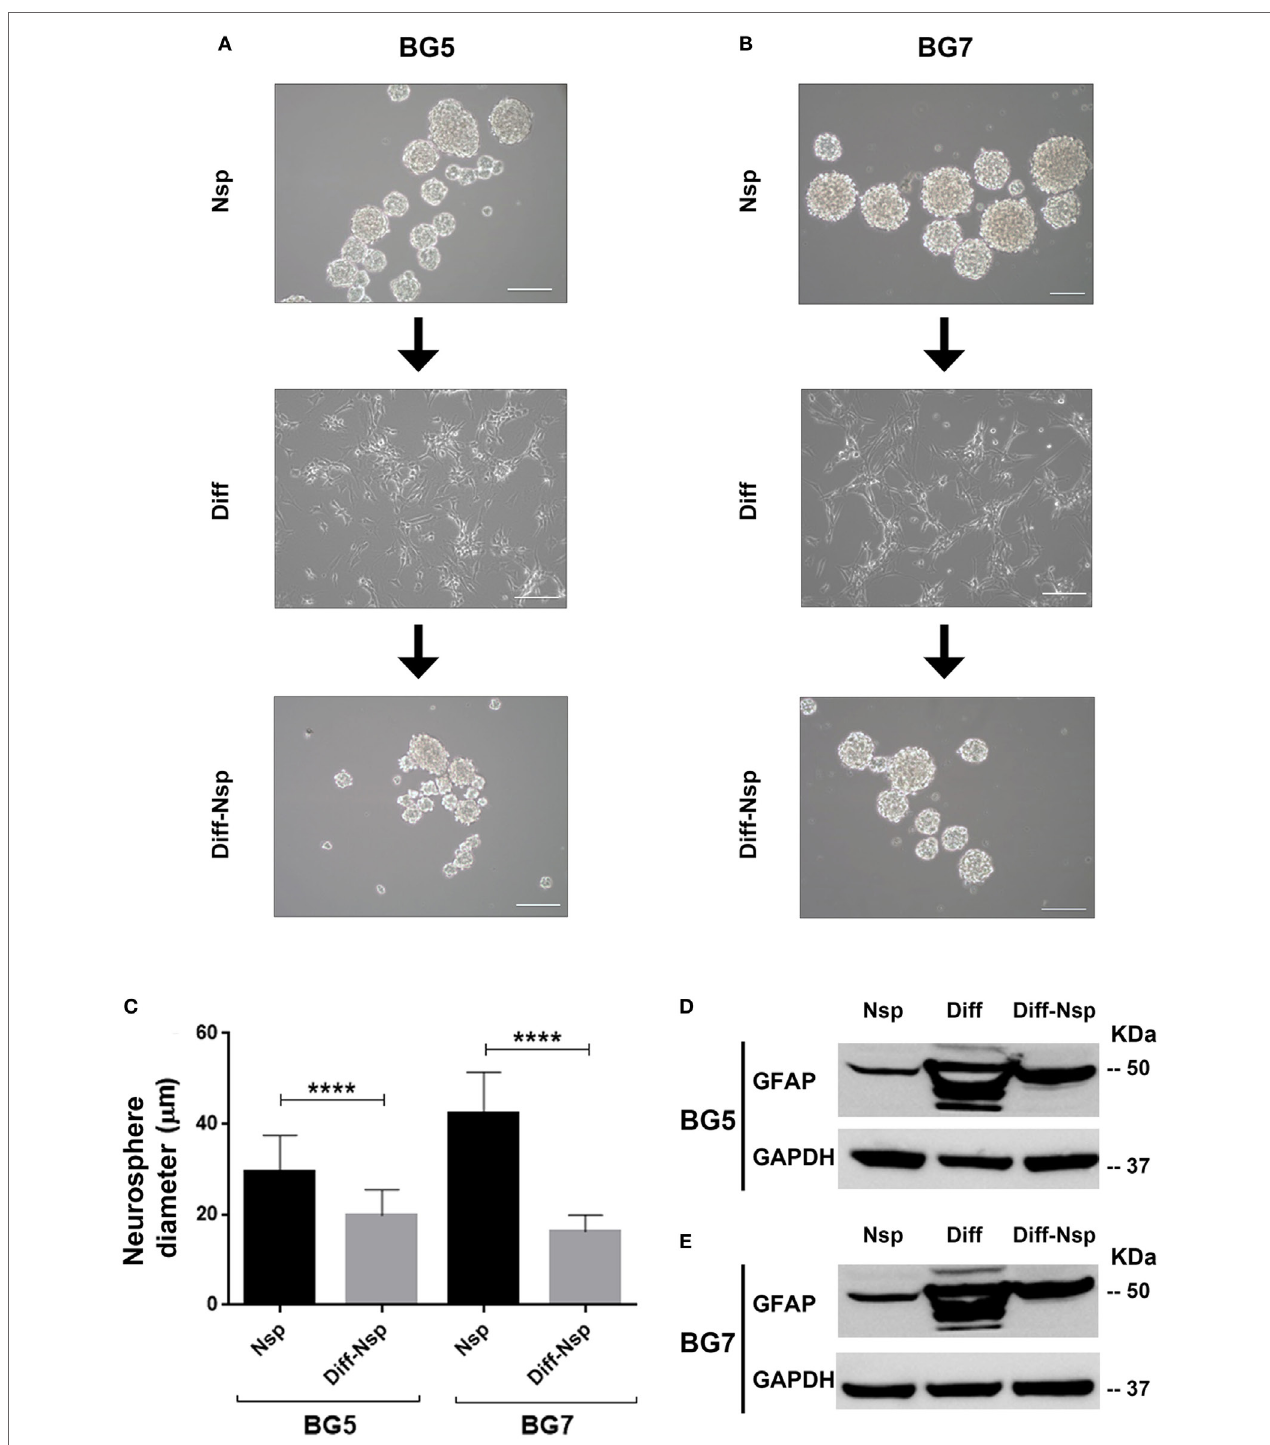
FigUre 2 | Differentiation and reversal of differentiation. Neurospheres (Nsp), differentiated to adherent cells (Diff) in 10% serum-containing medium and reverted back to a de-differentiated state (Diff-Nsp) after 14 days in stem-cell medium, (a) BG5 and (B) BG7 primary tumors. (c) Bar graph showing Nsp diameter in Nsp (black) and Diff-Nsp (gray) in BG5 and BG7 glioblastoma (GBM) cells. Data represent mean ± SD of n = 3 independent experiments per GBM patient-derived line. One-way ANOVA, Bonferroni’s multiple comparison test, **** P < 0.0001. Western blot showing glial acidic fibrillary protein and GAPDH in Nsp, differentiated, and de-differentiated Nsp (D) BG5 and (e) BG7 GBM